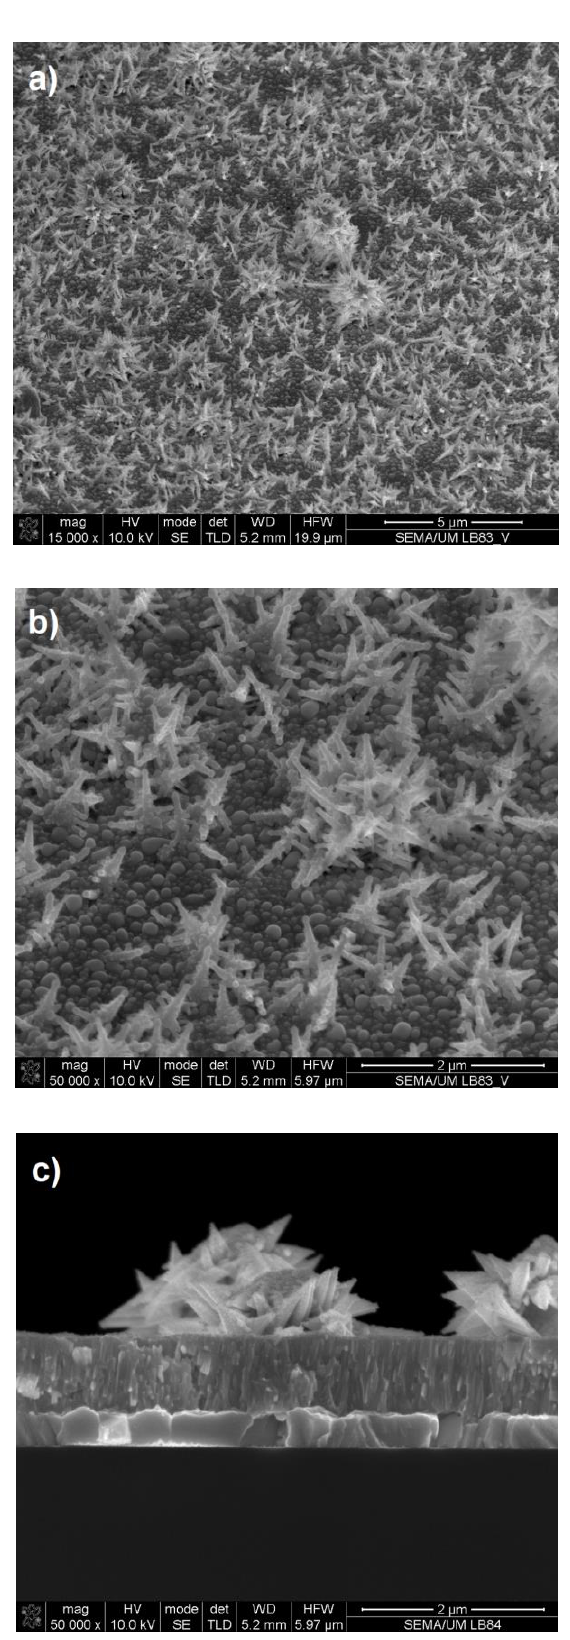
Figure 2. SEM micrographs taken from ( a ), ( b ) the surface and ( c ) cross-section of Bi/Bi 2 O 3 layers. Atomic force microscopy analysis enabled the determination of the roughness and projected surface area parameters of the Bi 2 O 3 layers. These quantities were calculated using the statistical